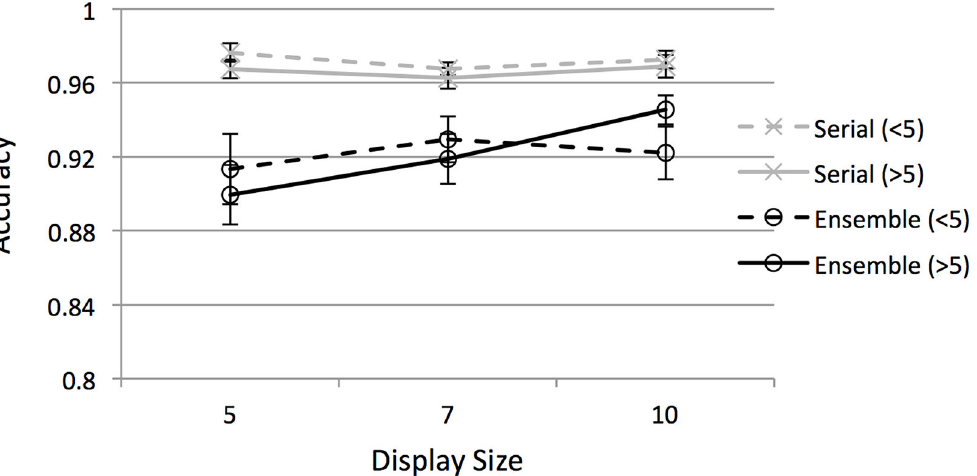
Figure 8. Accuracy for the serial search (gray) and ensemble (black) tasks in Experiment 2 plotted as a function of display size and separated by target type. Note. Dashed lines indicate < 5 and solid lines indicate > 5. Error bars represent standard error of the mean. Overall, accuracy was significantly higher for serial search compared to the ensemble task. Accuracy was not affected by display size for search, whereas larger display sizes led to greater accuracy for the ensemble